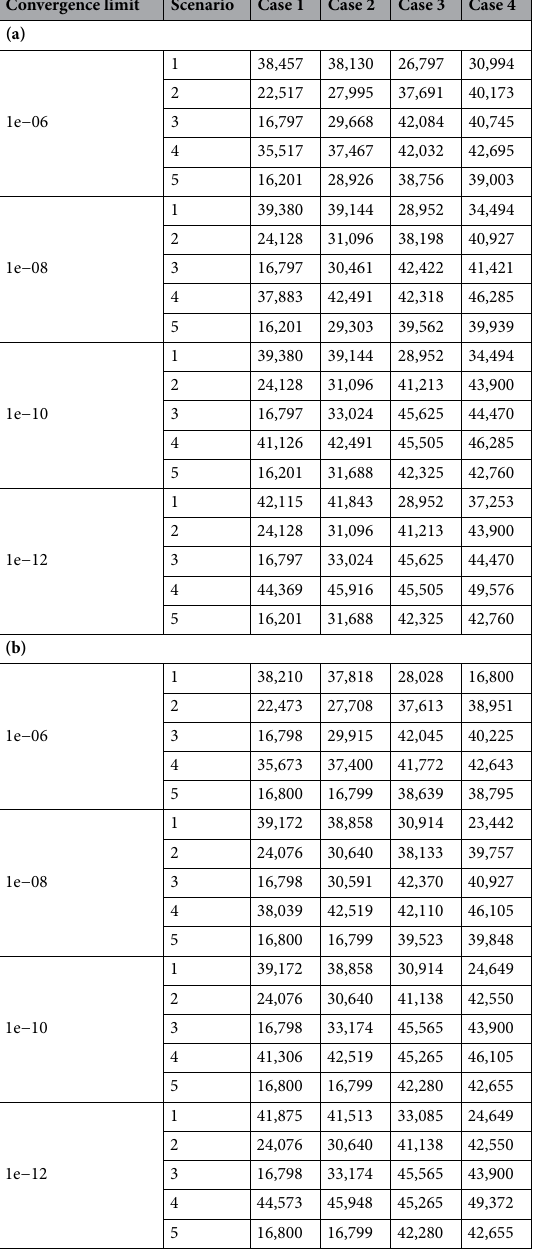
Table 5. Number of ODEs assessed for variants (a) Cu nanoparticles, (b) Silver